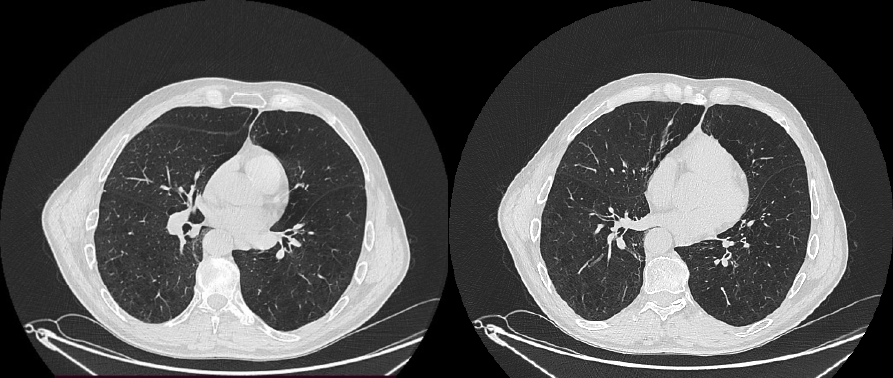
Figure 1. CT scan (2019) before COVID-19 infection, for evaluation of chronic respiratory insuffi- ciency—diffuse lung